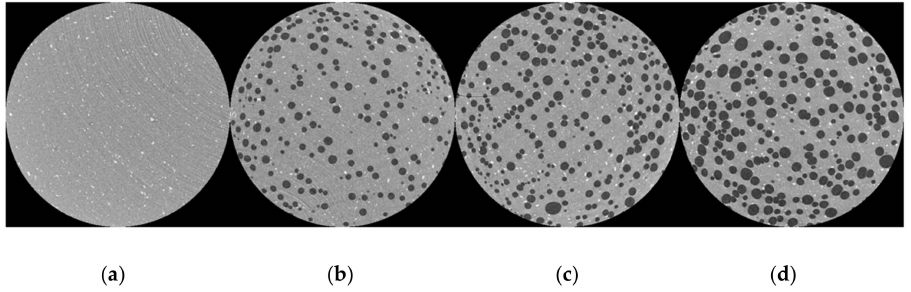
Figure 9. ( a ) µ CT scan of a sample with 0% voids. ( b ) µ CT scan of sample with 11.8% voids. ( c ) µ CT scan of sample with 19% voids. ( d ) µ CT scan of sample with 32.2%